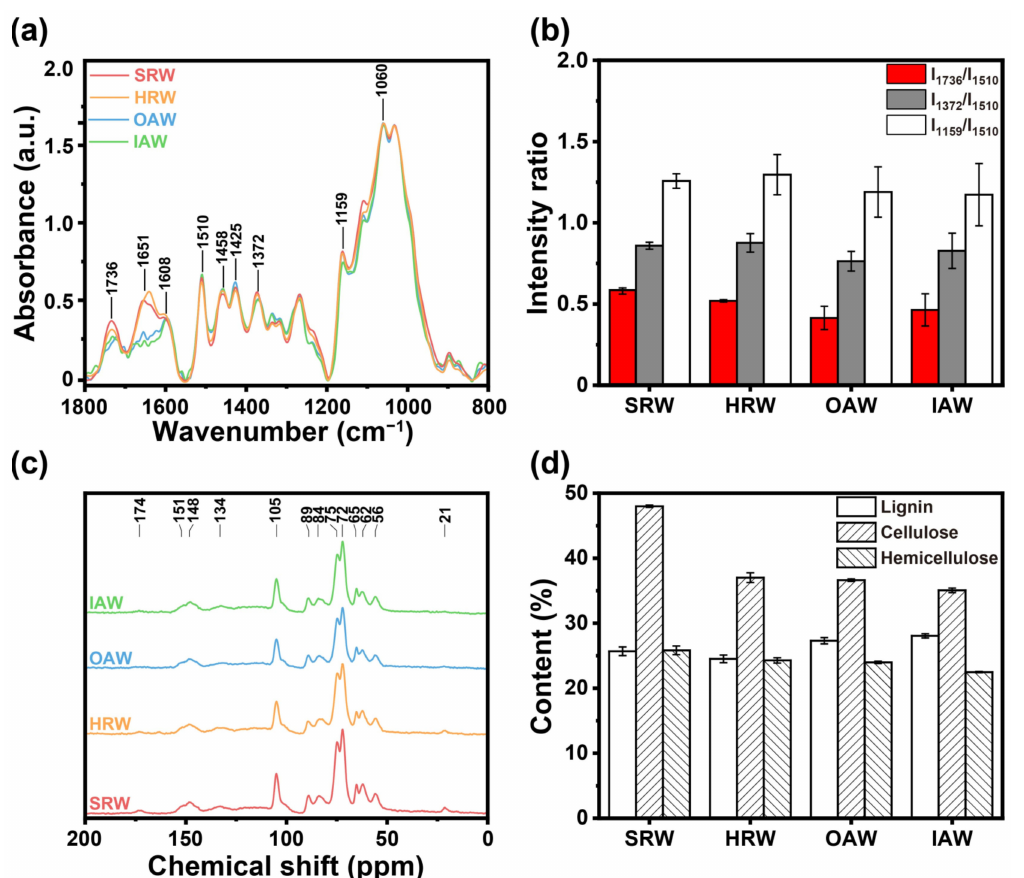
Figure 4. Chemical analysis of recent larch woods and ancient architectural woods. ( a ) Average FTIR absorbance spectra in 1800–800 cm − 1 . ( b ) The relative intensity ratio of I 1736 , I 1372 , and I 1159 versus I 1510 . ( c ) Solid-state 13 C NMR spectra. ( d ) Contents of lignin, cellulose, and